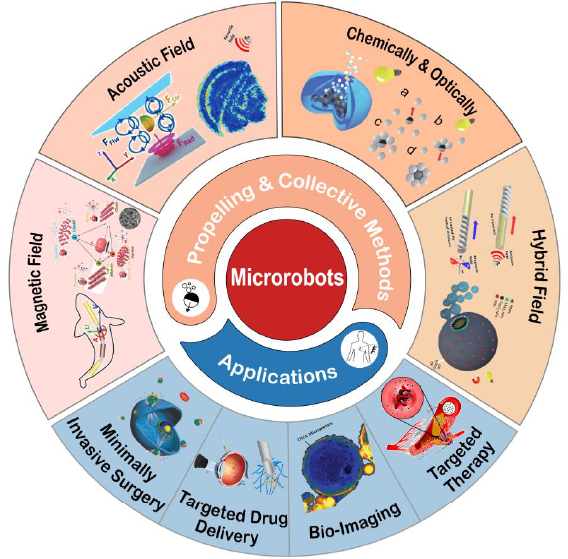
Figure 1. Schematic illustration of the key features and application scenarios of micro/nanorobots.